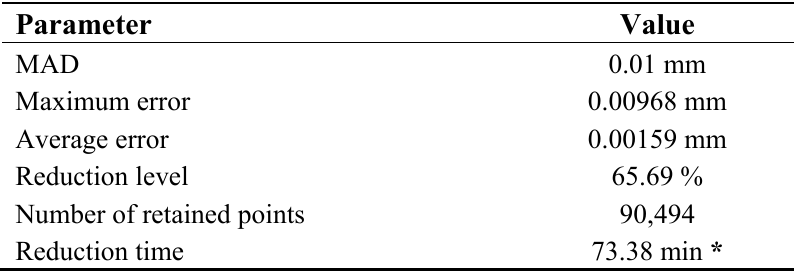
Table 1. The results of point data